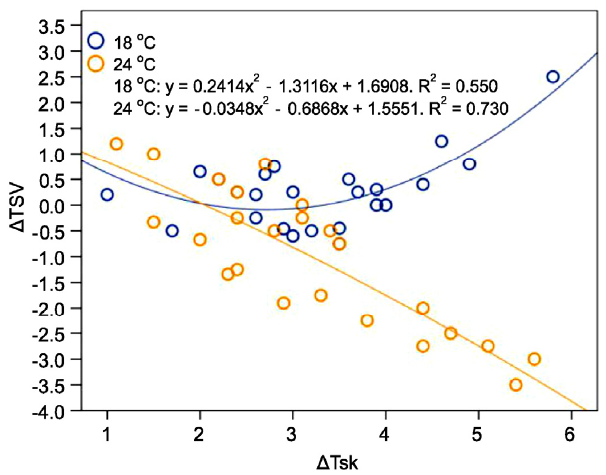
Figure 15. Relationship between Δ Tsk and Δ